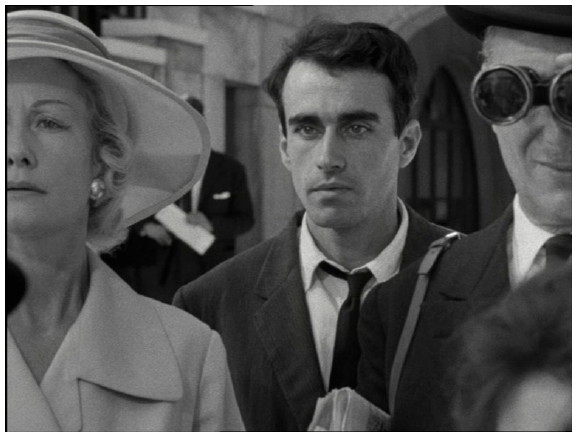
Figure 1. Michel about to start a career in pickpocketing. Source Artificial Eye: ART 295 DVD.